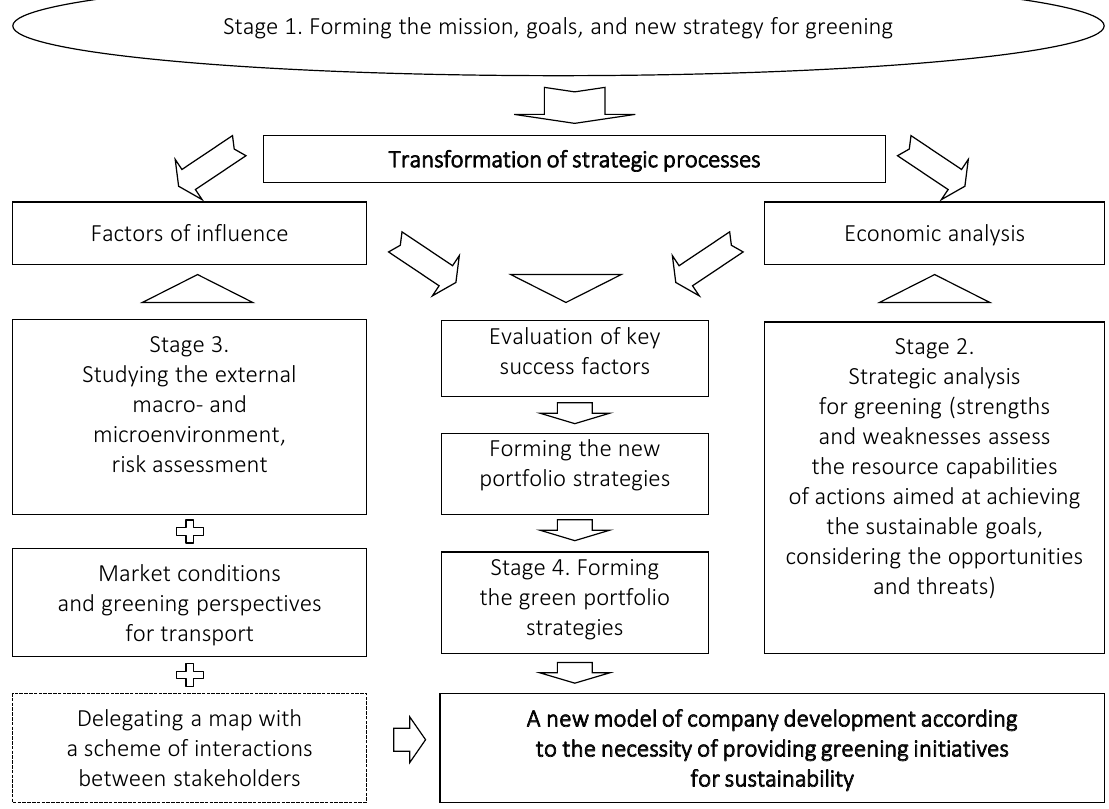
Figure 3. A sustainable model of strategic development management